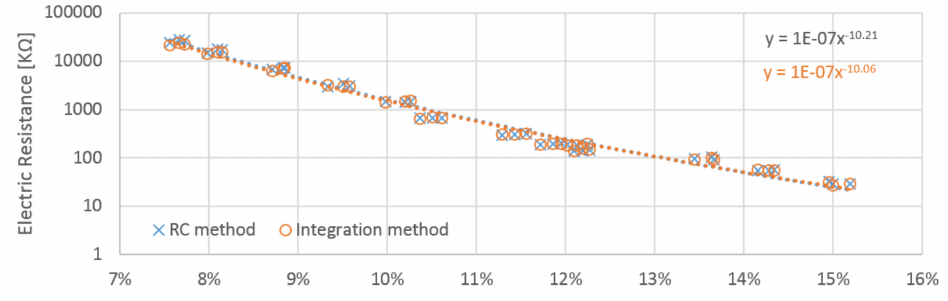
Figure 11. Obtained resistances from the integration and RC methods for the “B” probes placed on the right sides of the samples.